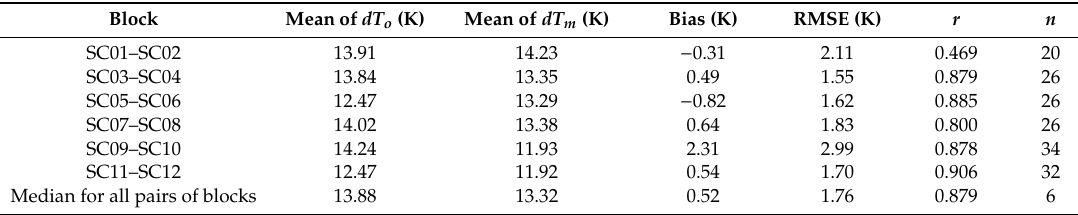
Table 3. Agreement between modeled and observed dT values for the sampling blocks in the South-central